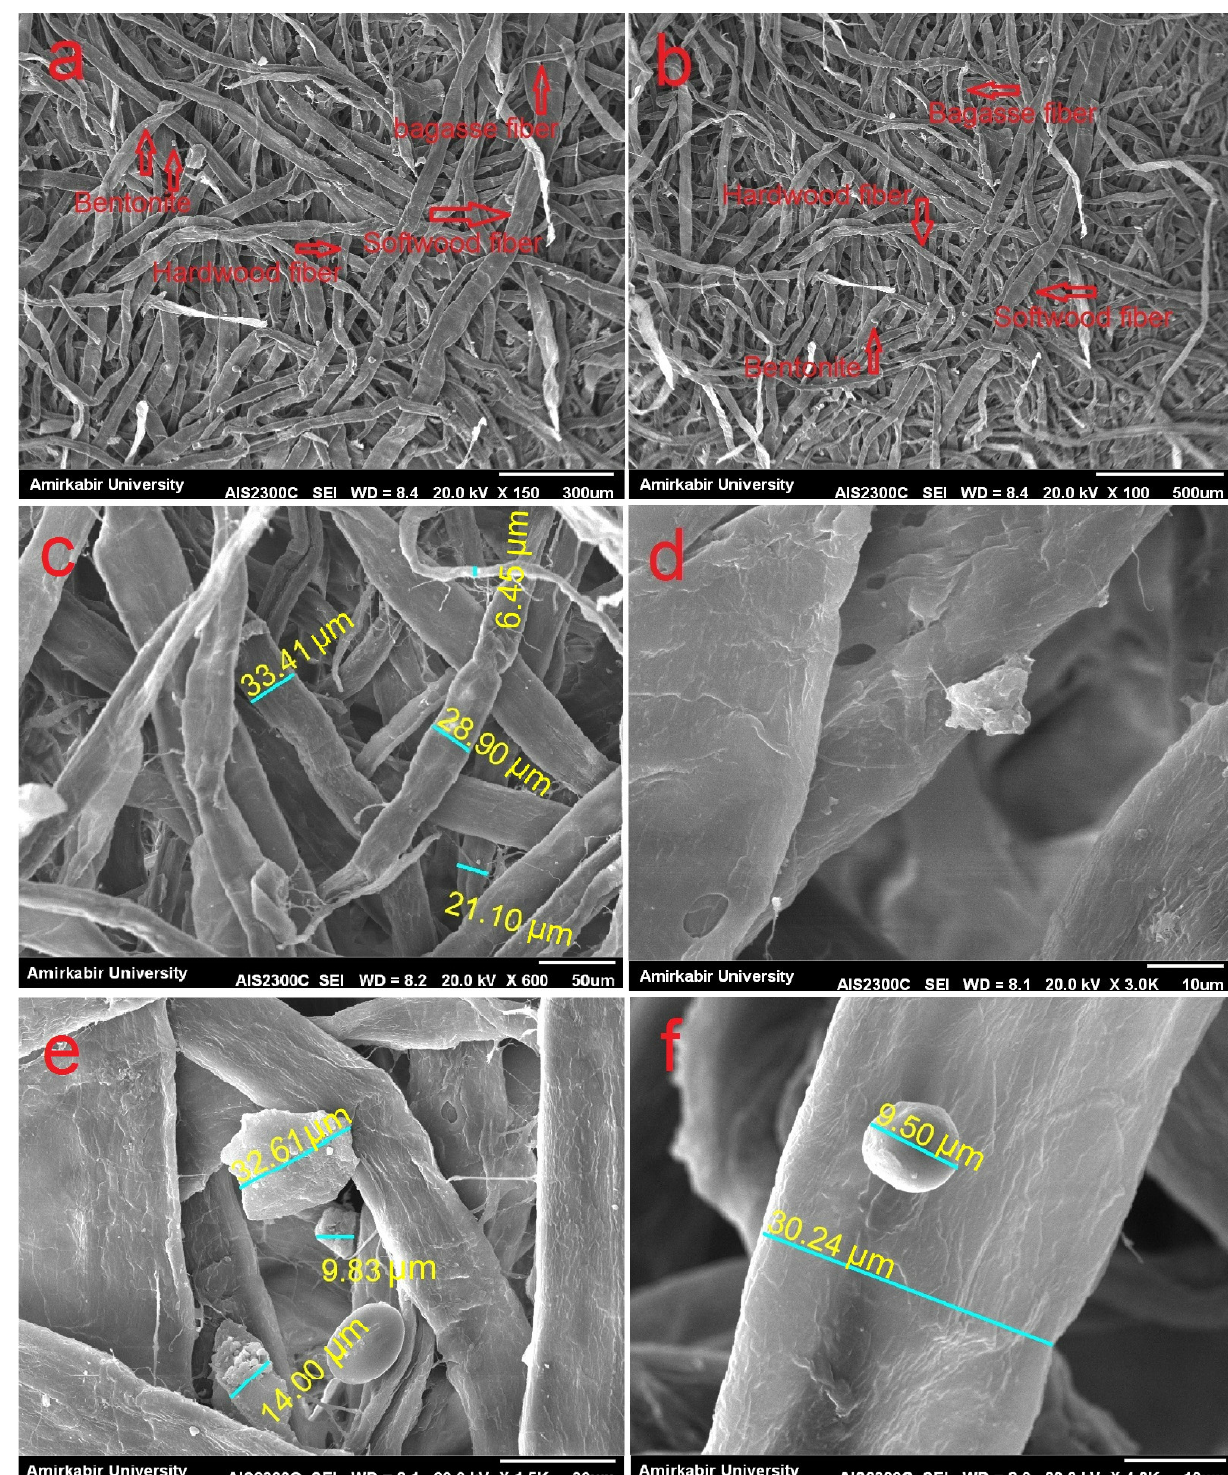
Figure 2. SEM images of fluff pulp with 50S15H35B formulations, distribution of softwood pulp, hardwood pulp and bagasse pulp ( a , b ), fiber sizes ( c ) and presence of bentonite on the surface of fibers ( d – f